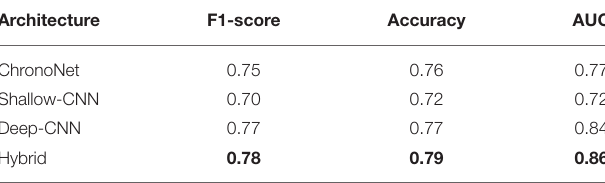
TABLE 3 | Performance of different architectures on the NMT